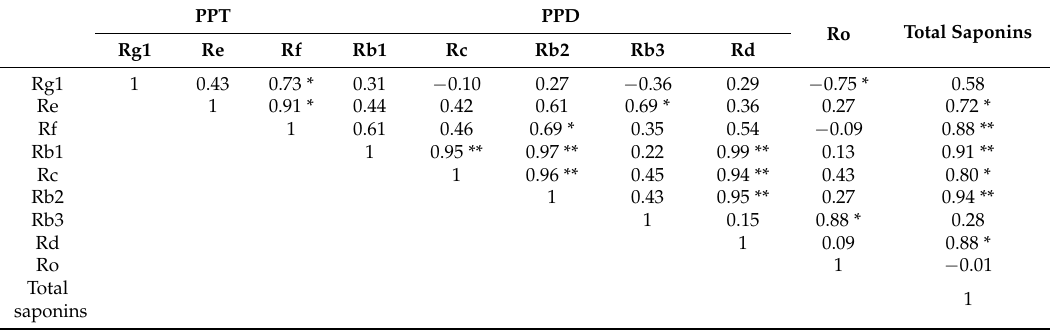
Table 3. Correlation analysis of individual ginsenosides and total saponins in roots at different growth times. PPT